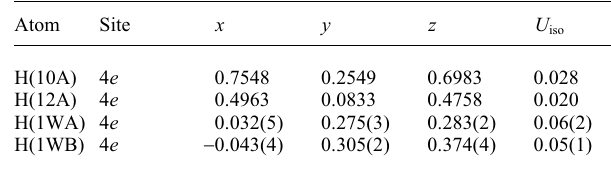
Table 2. Atomic coordinates and displacement parameters (in Å 2 ) .